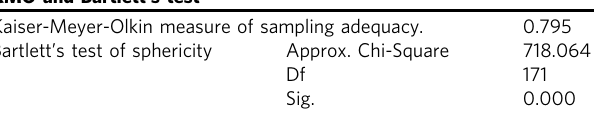
Table 8 KMO and Bartlett ’ s test of sphericity of output QA for teaching and learning construct. KMO and Bartlett ’ s test